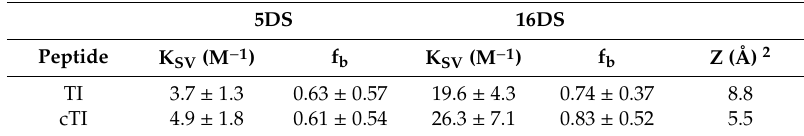
Table 9. Fluorescence quenching of tachyplesin I (TI) and and cyclic tachyplesin I (cTI) partitioned into 1 mM POPC / POPS (4:1) LUVs by the quenchers 5DS and 16DS. 1.